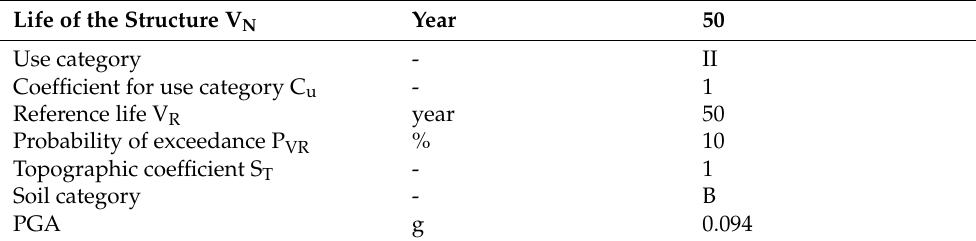
Table 2. Response spectrum